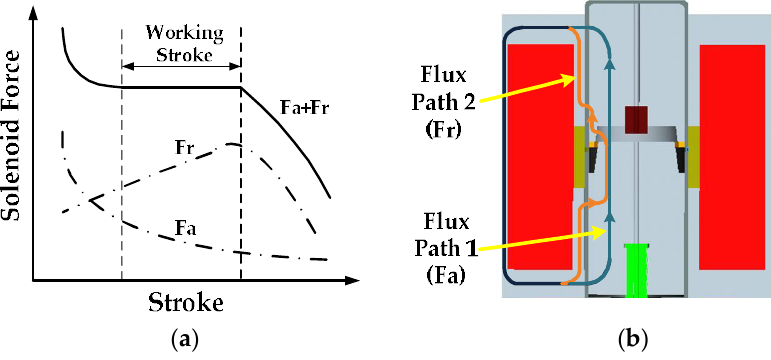
Figure 5. Relation between solenoid force and stroke: ( a ) form of force; and ( b ) flux path mode.